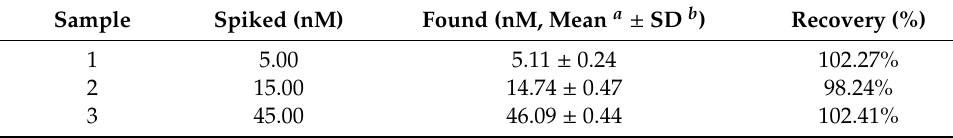
Table 1. Fluorescent assay of Pb 2+ in spiked lake water samples using DNAzyme-R-PE ( n = 5).